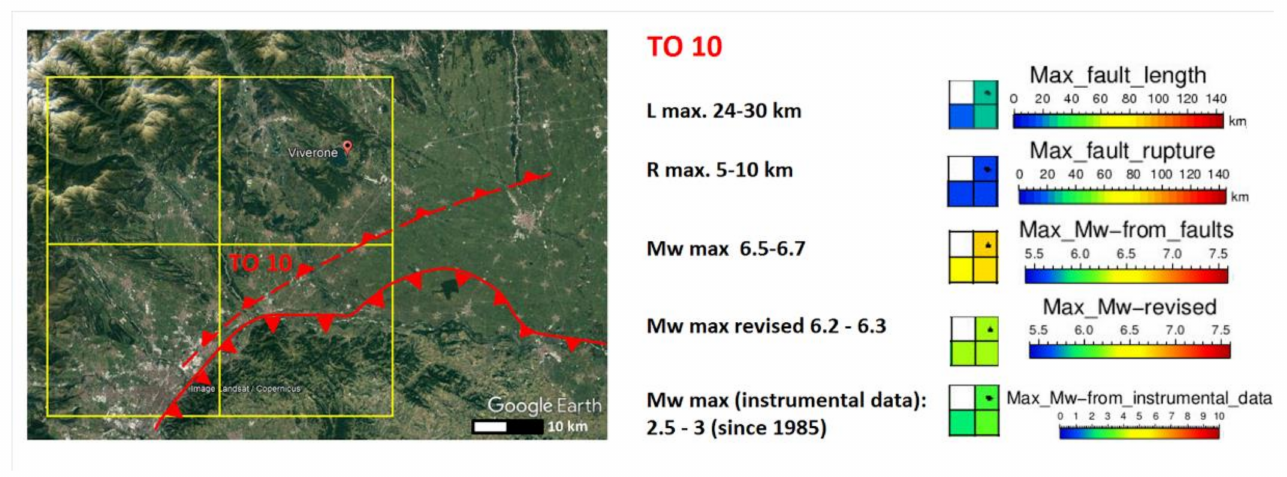
Figure 4. In yellow the considered 25 km × 25 km quadrants of the “ Map of the maximum expected magnitude on geological- geophysical basis ” (base from Google Earth). Numerical values are those reported in the Sogin DN-GS-00095 [23] for the quadrant containing the TO-10 site. Simplified traces of the Apennine Frontal Thrusts (AFT) and the Median Front of Alpine (MFA) retrovergent units are, also,